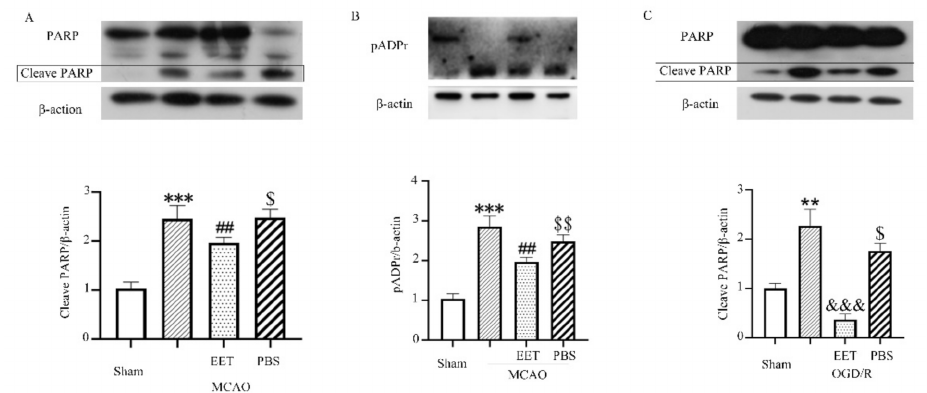
Figure 3. PARP-1 activity following cleavage was detected with Western blot. ( A ) PARP-1 cleavage was detected in total brain protein at 22 h after middle cerebral artery occlusion and reperfusion in mice. ( B ) Poly (ADP-ribosylation) was detected in total brain protein at 22 h after middle cerebral artery occlusion and reperfusion in mice. ( C ) PARP-1 cleavage was detected in total protein of primary cortical neurons at 24 h after OGD/R. (** p < 0.01,*** p < 0.001 vs. sham; ## p < 0.001 vs. MCAO; $ p < 0.05, $$ p < 0.01 vs. sham; &&& p < 0.001 vs. OGD/R; n = 3).